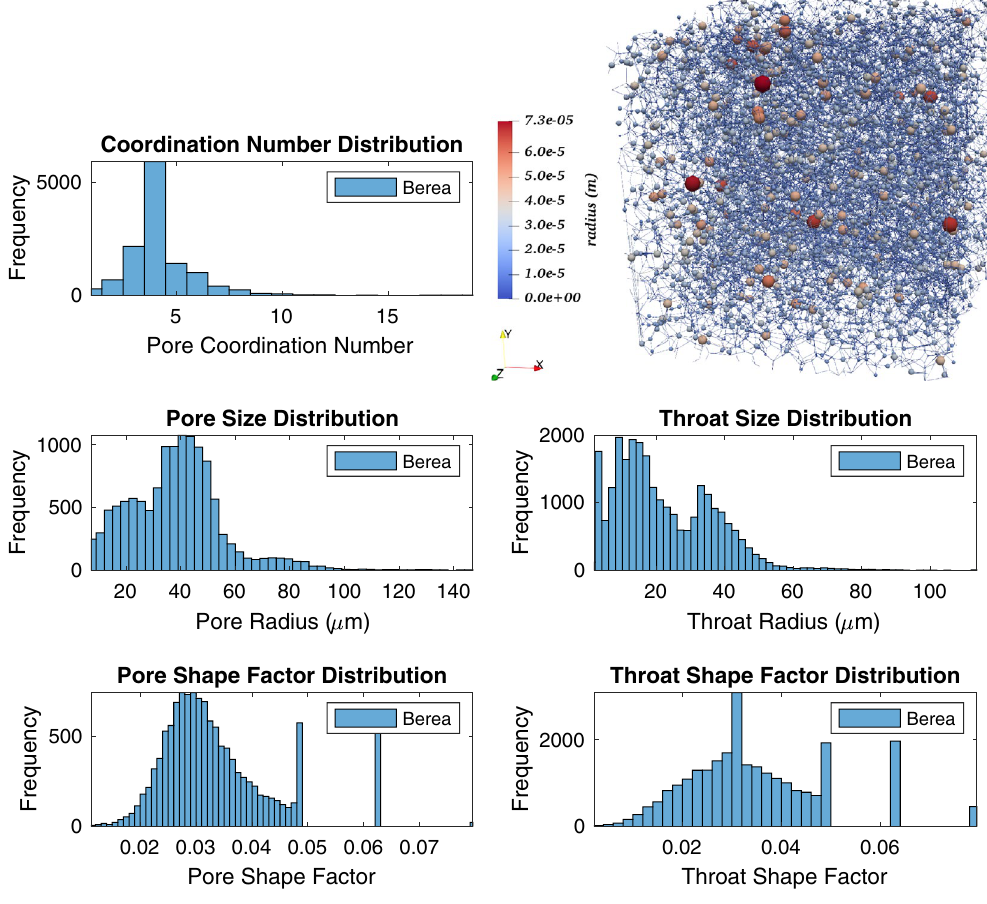
Figure 3. Illustration of the pore network model characteristics for Berea sandstone 47 .